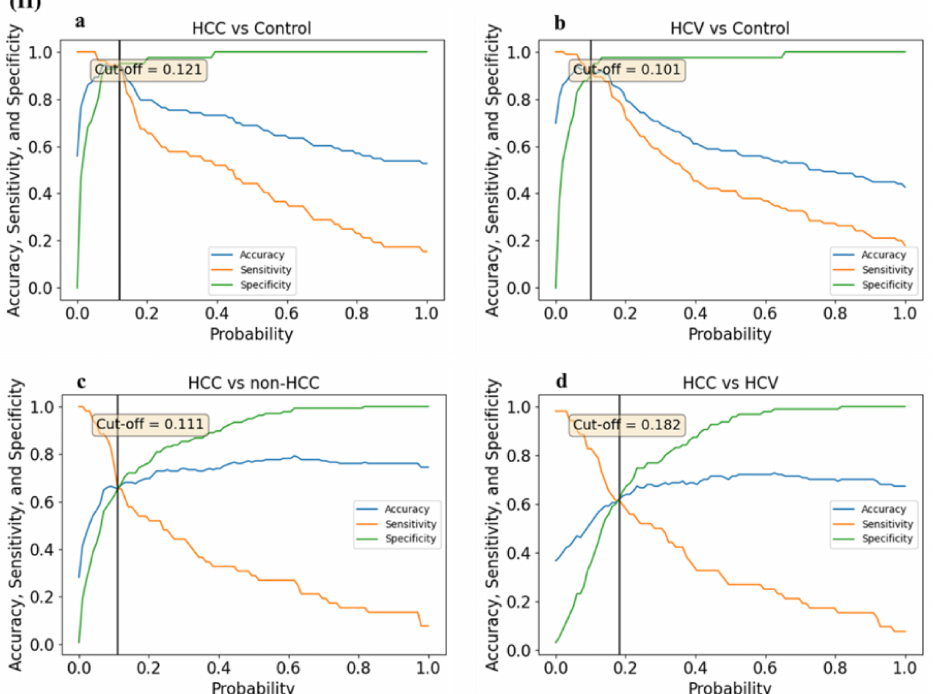
Figure 14. ROC analysis for the predictive diagnostic ability of the target miRNAs combined panels using logistic regression analysis. ( I ) ROC curves of the miRNAs combined panel comparing ( a ) HCC patients to healthy individuals, ( b ) HCV patients to healthy individuals, ( c ) HCC patients to non-HCC individuals, and ( d ) HCC to HCV infected patients. ( II ) Plot of the computed sensitivity, specificity, and accuracy highlighting the predictive ability of the miRNAs combined panels in ( a ) HCC patients to healthy individuals, ( b ) HCV patients to healthy individuals, ( c ) HCC patients to non-HCC individuals, and ( d ) HCC to HCV infected